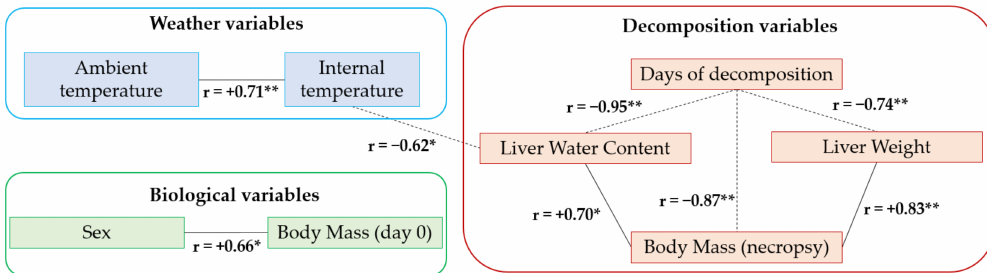
Figure 5. Significant relationships between weather variables (ambient and internal temperatures), biological variables (sex and body mass on day 0), and decomposition variables (days of decomposition, liver weight, liver water content and body mass during necropsy) in common kestrels. Pearson correlation coe ffi cients (r) are presented. The directions of the relationships are shown with positive and solid lines, or negative and dashed lines. * p < 0.05, ** p ≤